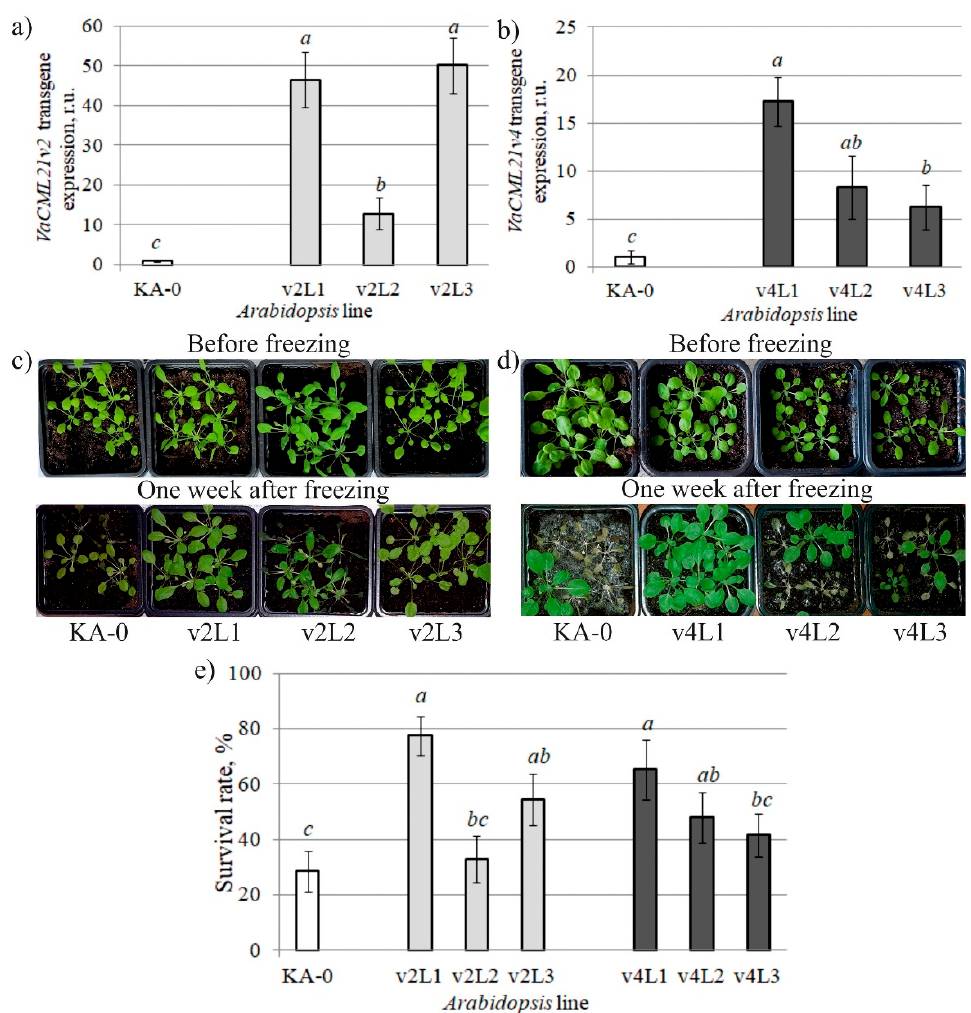
Figure 5. Characterization and responses to freezing of vector control (KA-0), VaCML21v2- (v2L1, v2L2, v2L3) and VaCML21v4 -transgenic (v4L1, v4L2, v4L3) Arabidopsis . ( a , b ) Quantification of the VaCML21v2 and VaCML21v4 mRNAs in A. thaliana performed by qRT-PCR. ( c , d ) 4-week-old KA-0 and VaCML21 -transgenic plants were stressed at − 10 °C for 45 min and then cultured at +4 °C for 1 h for recovery. Photographs of representative seedlings were taken after 7 d of recovery. ( e ) Survival rates determined as the number of visibly green plants 7 d after freezing. Values are the mean ± SE. Six plants of each line were used in each of ten experiments. Means followed by the same letter were not different using one-way analysis of variance (ANOVA), followed by the Tukey HSD multiple comparison test. A value of p ≤ 0.05 was considered as significant.